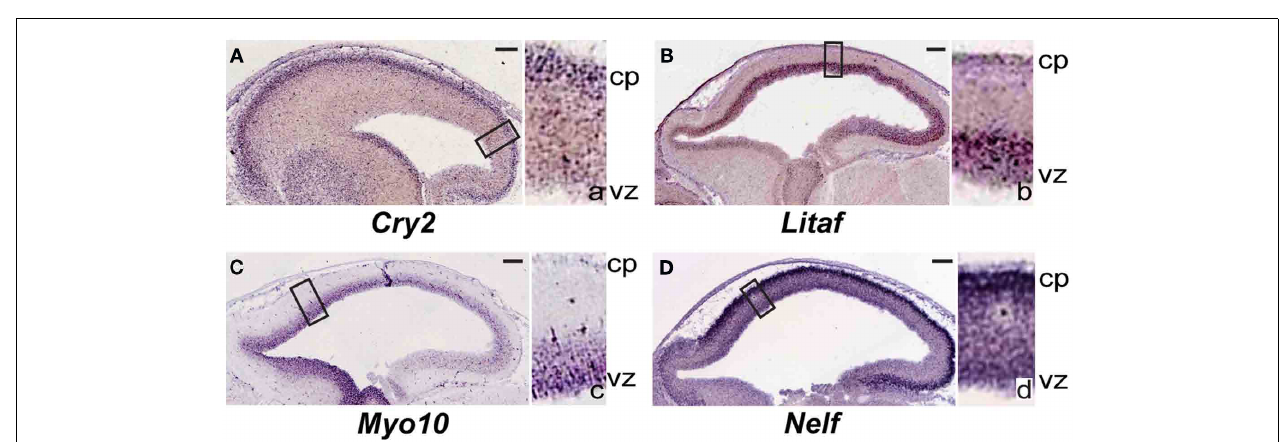
areas in the main images; these are denoted by the corresponding lower-case letter. (A) Cry2 is predominantly expressed in the developing cortical plate. Litaf (B) and Myo10 (C) are expressed strongly in the ventricular zone. (D) Nelf is highly expressed in the developing cortical plate, and also diffusely throughout the thickness of the cortex. cp, cortical plate; vz, ventricular zone. Scale bars, 100 μ m. See text for details.